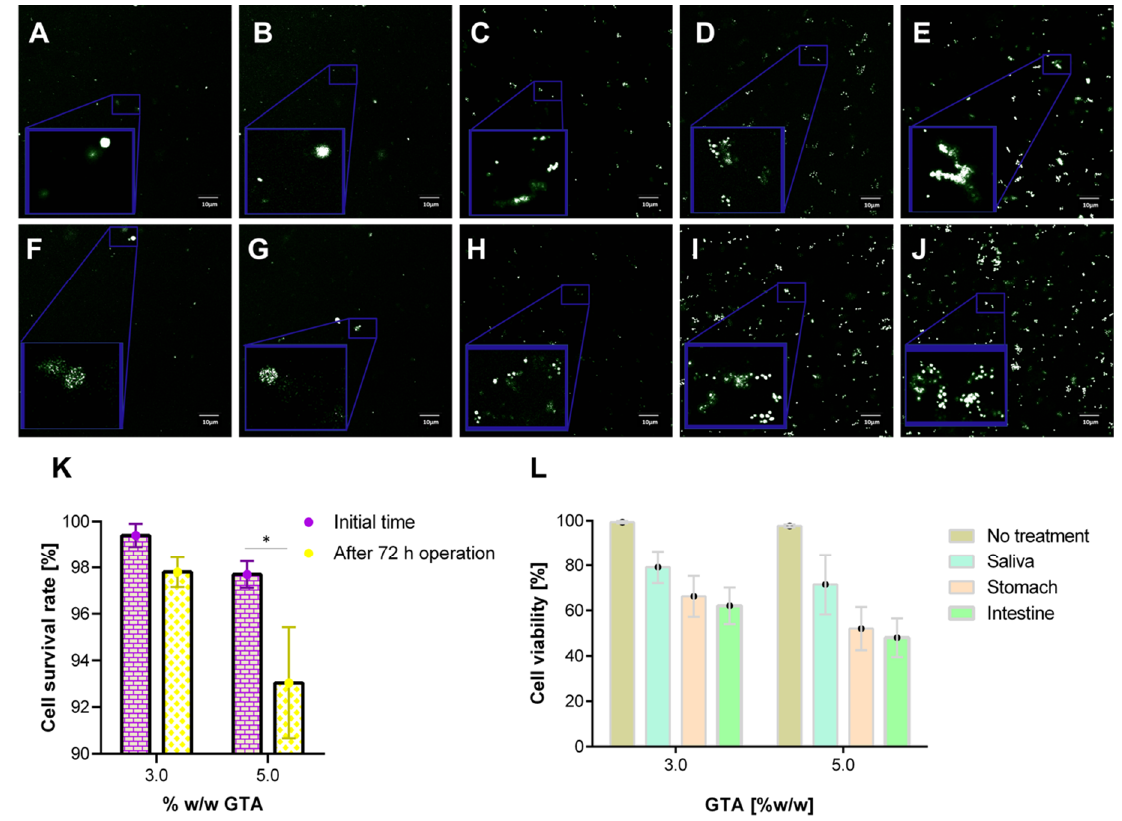
Figure 11. Confocal microscopy images. Dead cells are shown in white color while live cells in green. Scale bar corresponds to 10 µ m. ( A ) Live / dead K. lactis cells in the encapsulates made with 3.0% (w / w) GTA. ( B ) Live / dead K. lactis cells in the encapsulates made with 3.0% (w / w) GTA after 72 h of bioreactor operation. ( C ) Live / dead K. lactis cells in the encapsulates made with 3.0% (w / w) GTA after exposure to simulated saliva medium. ( D ) Live / dead K. lactis cells in the encapsulates made with 3.0% (w / w) GTA after exposure to simulated stomach medium. ( E ) Live / dead K. lactis cells in the encapsulates made with 3.0% (w / w) GTA after exposure to the simulated small intestine medium. ( F ) Live / dead K. lactis cells in the encapsulates made with 5.0% (w / w) GTA. ( G ) Live / dead K. lactis cells in the encapsulates made with 5.0% (w / w) GTA after 72 h of bioreactor operation. ( H ) Live / dead K. lactis cells in the encapsulates made with 5.0% (w / w) GTA after exposure to simulated saliva medium. ( I ) Live / dead K. lactis cells in the encapsulates made with 5.0% (w / w) GTA after exposure to simulated stomach medium. ( J ) Live / dead K. lactis cells in the encapsulates made with 5.0% (w / w) GTA after exposure to the simulated small intestine medium. In all images, the inset corresponds to a zoom of a region of interest. Yeast probiotic cell survival rate for encapsulates before and after bioreactor operation ( K ) and after treatment with each of the gastrointestinal tract simulated media ( L ).